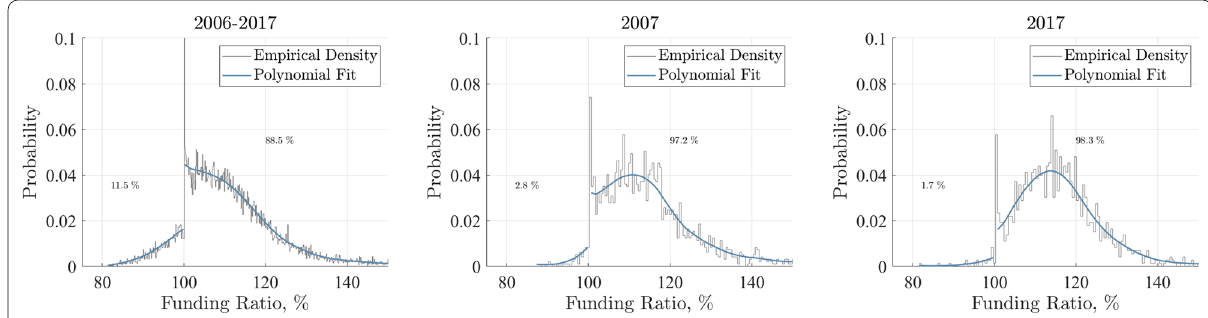
Fig. 1 Distribution of Funding Ratios. Distributions of the funding ratios of pension funds pooled across all years 2006–2017, in 2007 , and in 2017. The solid line shows the smoothed fit using a local 4th-order polynomial kernel regression to the left and to the right of 100%. Binwidth of histogram and bandwidth of triangular kernel are based on the procedure by McCrary (2008). Bin at 100% omitted for polynomial fit. Figure shows spike exactly at the regulatory minimum (100%). The corresponding McCrary test for discontinuity between left and right of 100% (omitting the 100% bin) is positive and significant. The sample includes only private and public funds without state guarantees and only includes funds with a funding ratio between 81.5 and 152.3% (0.5th–95th percentile